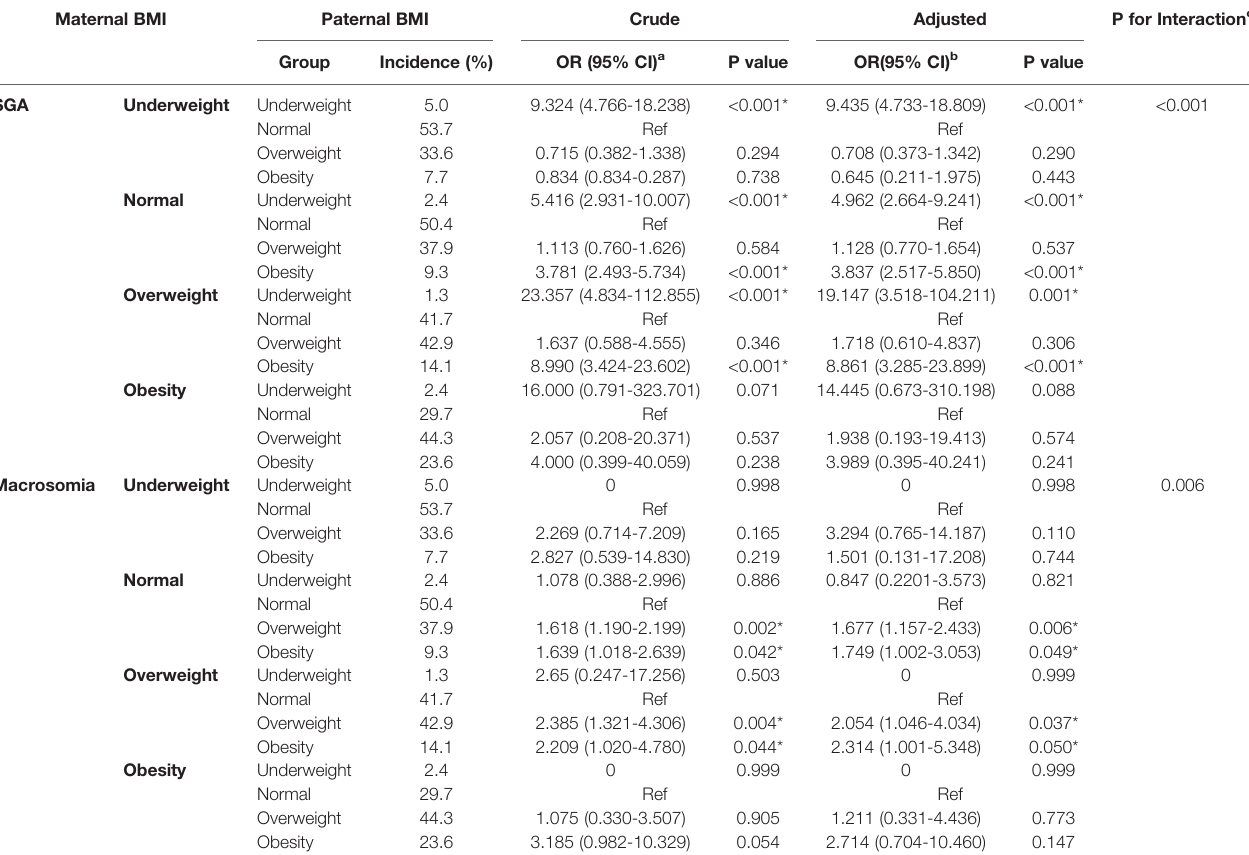
TABLE 4 | Paternal BMI and the risk of SGA/macrosomia was analyzed by logistic regression, strati fi ed by maternal BMI. Maternal BMI Paternal